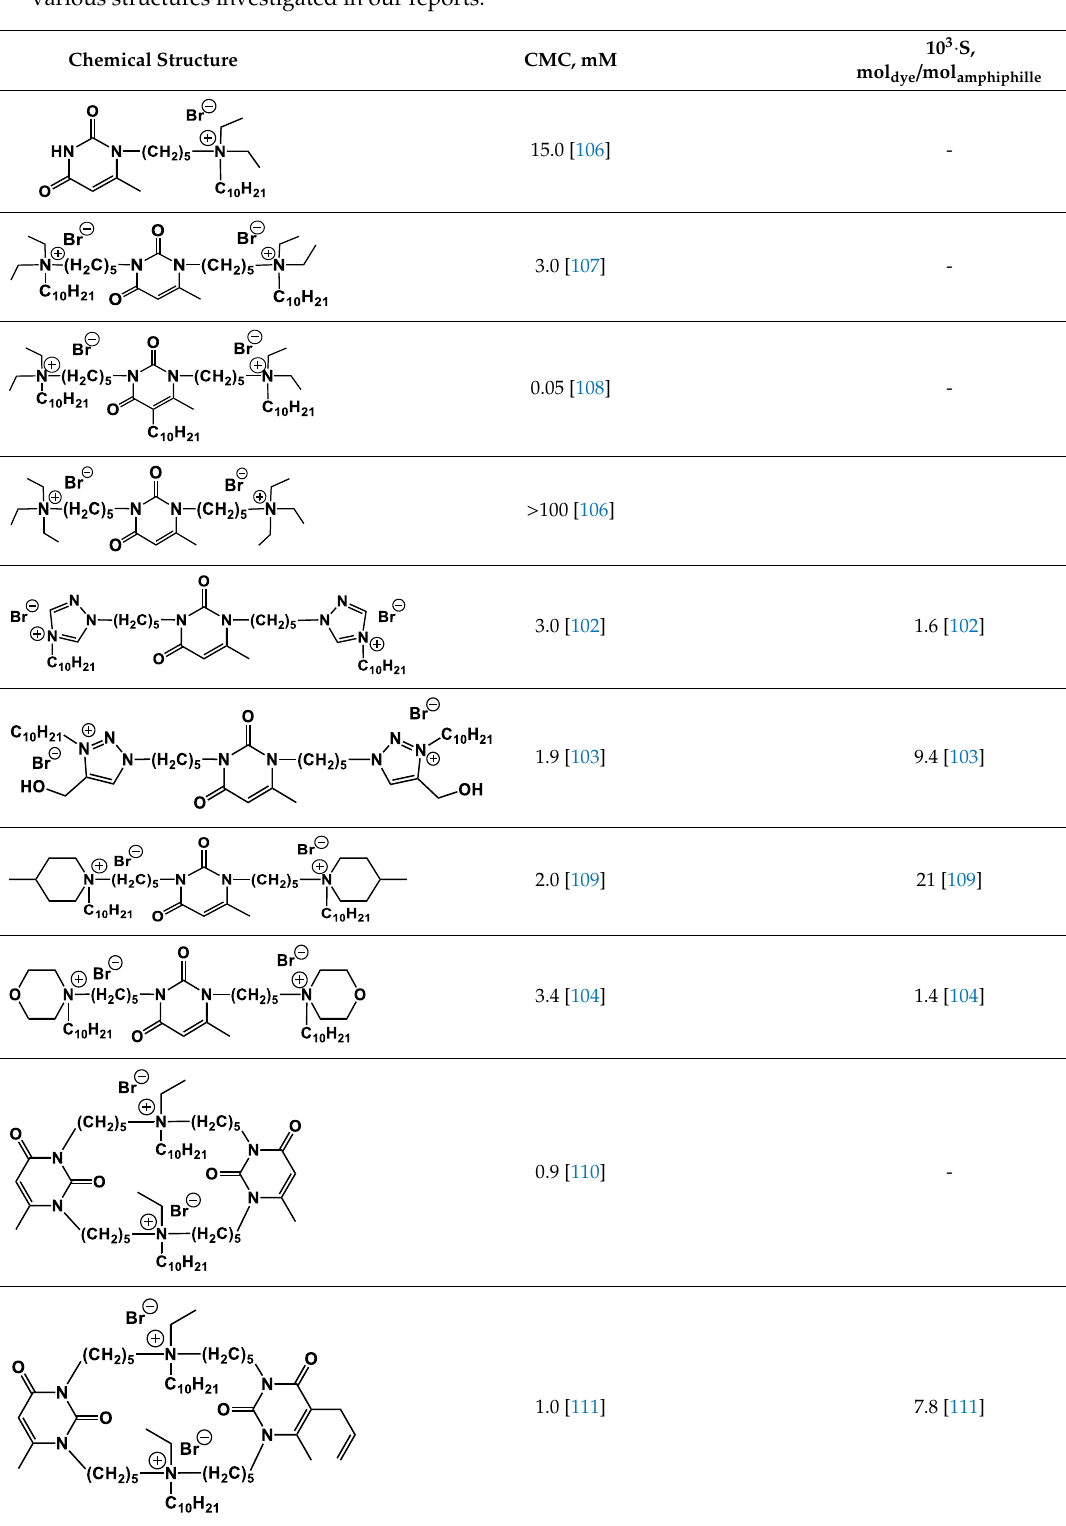
Table 3. CMC values and solubilization power S toward hydrophobic Orange OT for nucleolipids of various structures investigated in our reports.